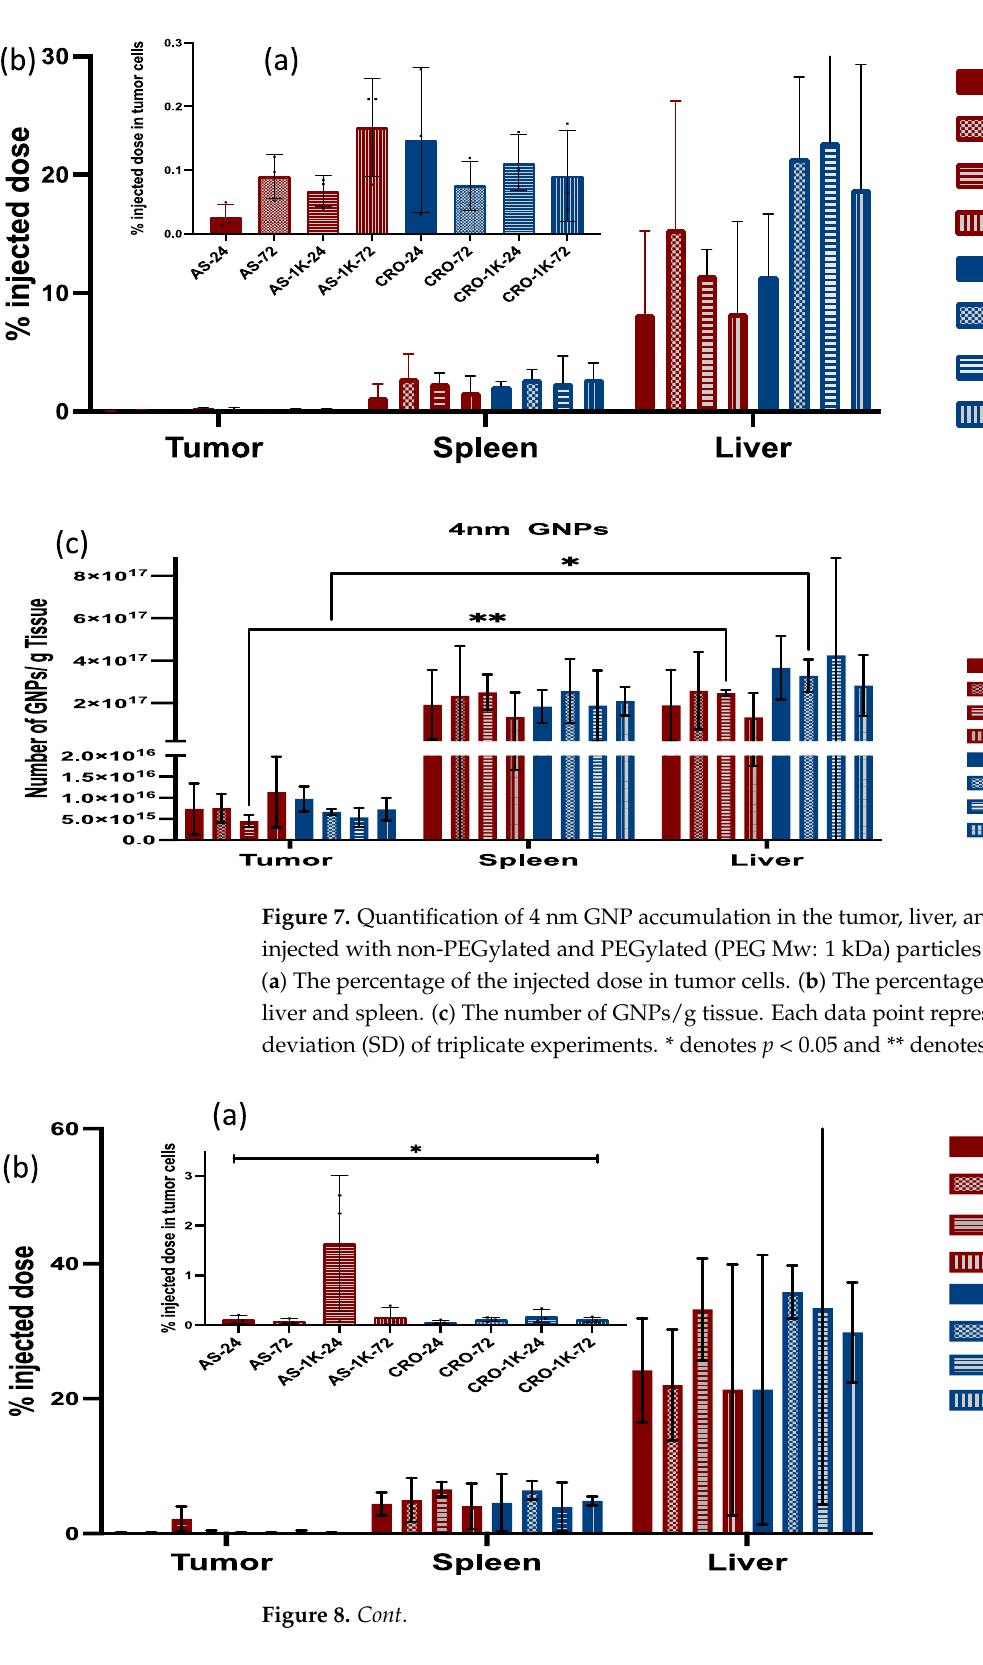
Figure 8. Quantification of 10 nm GNP accumulation in the tumor, liver, and spleen of mice that were injected with non-PEGylated and PEGylated (PEG Mw: 1kDa) particles 24 and 72 h post-injec- tion. ( a ) The percentage of the injected dose in tumor cells. ( b ) The percentage of the injected dose in the liver and spleen. ( c ) The number of GNPs/g tissue. Each data point represents the mean ± standard deviation (SD) of triplicate experiments. * denotes p < 0.05 and ** denotes p < 0.01. The uptake of the 10 nm PEGylated GNPs/AS1411 by tumor cells was significantly higher than the other particles at 24 h ( p = 0.0162). 10 nm PEGylated GNPs/CRO displayed a slight increase compared with the non-PEGylated ones although the difference is non- significant. The results of the in vivo study revealed that PEGylation increases the uptake by tumor cells (especially 10 nm GNPs) for particles with AS1411, and in general, we ob- served that the uptake of large particles (10 nm) by the liver and the spleen is higher than the uptake of small ones (4 nm). 4. Discussion In this study, we have demonstrated the synthesis and the characterization of a series of GNP-based MRI contrast agents using two sizes of GNPs (4 and 10 nm) fabricated with a gadolinium chelate, either AS1411 or CRO oligonucleotides, and with or without PEG 1, 2, and 5 kDa. UV–vis absorption spectra, DLS, and zeta potential were acquired and reported. The protein corona that formed around the nanoparticles was purified from the GNPs and quantified by a BCA assay after incubation of the particles in 10% human serum for 24 h. PEGylation had an increased amount of protein binding with all the GNPs con- taining AS1411, while it decreased protein binding to the GNPs containing the CRO oli- gonucleotide. The role of PEG in protein adsorption is controversial in the literature, where many studies have shown that PEG provides a steric barrier that mitigates protein